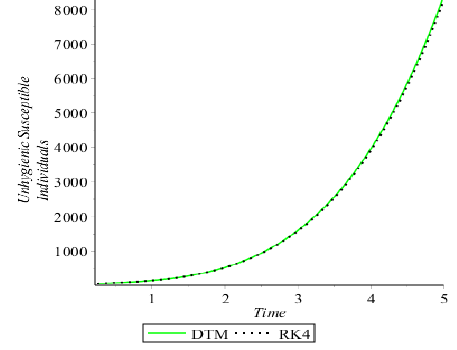
Figure 2: Solution of Unhygienic Susceptible Individuals